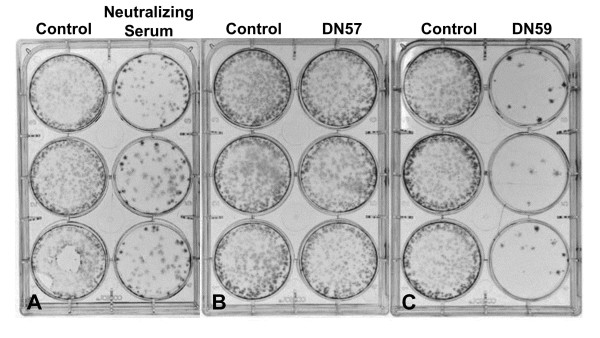
Plaque inhibition assay. (A) Preincubation of DENV with neutralizing antiserum reduces plaque number by 74%. (B) Preincubation of DENV with a non-inhibitory peptide shows no reduction in plaques. (C) Preincubation of DENV with one of the inhibitory peptides (DN59) shows a greater than 95% reduction in plaques.